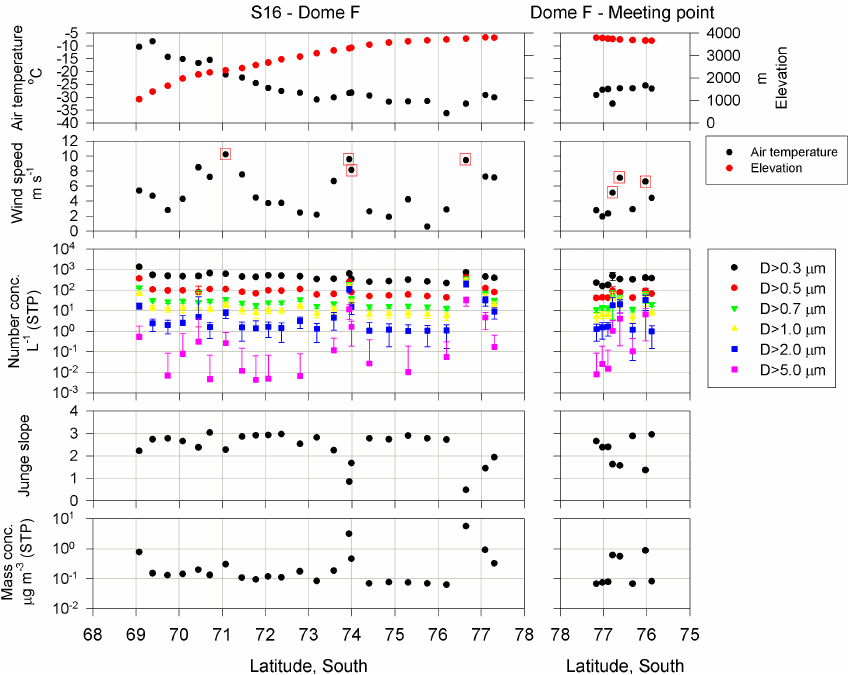
Figure 4. Horizontal features of air temperature, elevation, wind speed, aerosol number concentrations and Junge slope during incoming traverse from S16 to the meeting point. Red boxes show conditions with drifting snow.